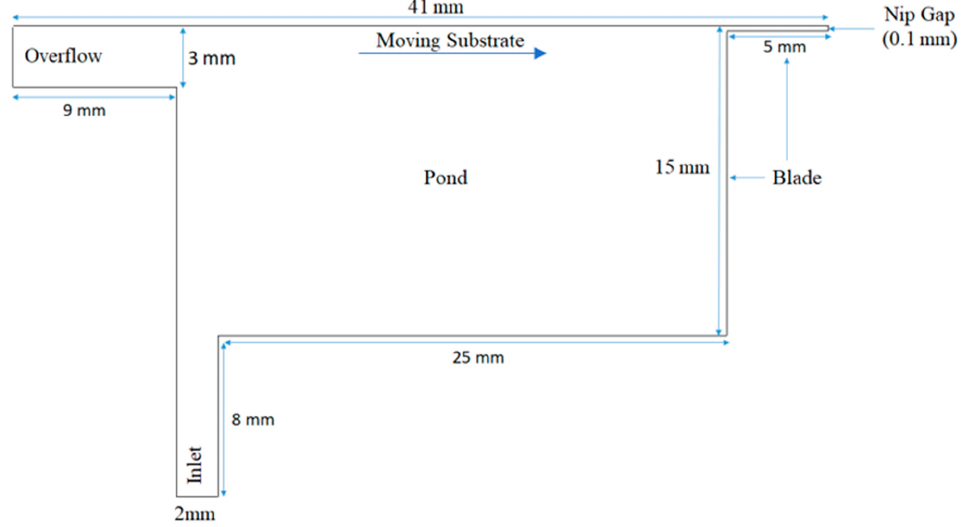
Figure 1. Schematic representation of the short-dwell coater (SDC)